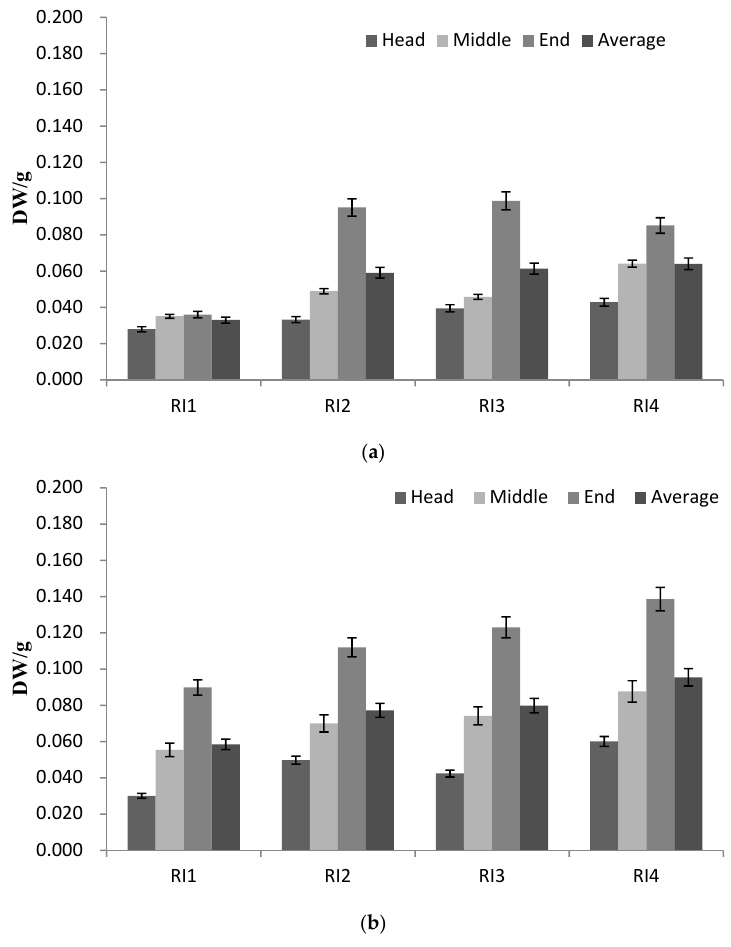
Figure 4. Quantitative analysis of dry weight (DW) under different fresh-saline alternating irrigation models in 2013 ( a ) and 2014 ( b ). Table 4. T -test of DW under different fresh-saline alternating irrigation models.